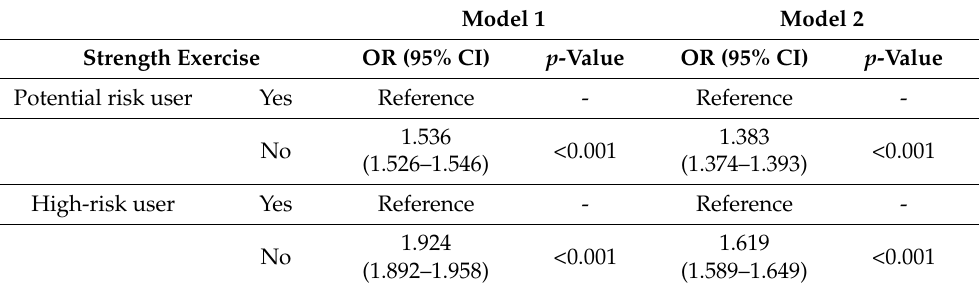
Table 5. Logistic regression analysis on level of smartphone addiction based on strength exercise.